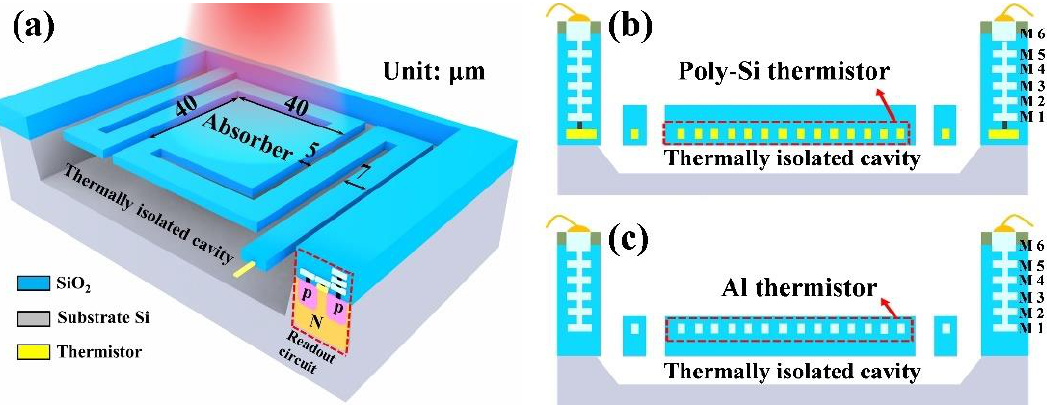
Figure 1. ( a ) 3D schematic illustration of the proposed microbolometer using 0.18 μm standard CMOS technology. The cross-section views of the suggested microbolometer with ( b ) salicide polysilicon thermistor and ( c ) metal Al.